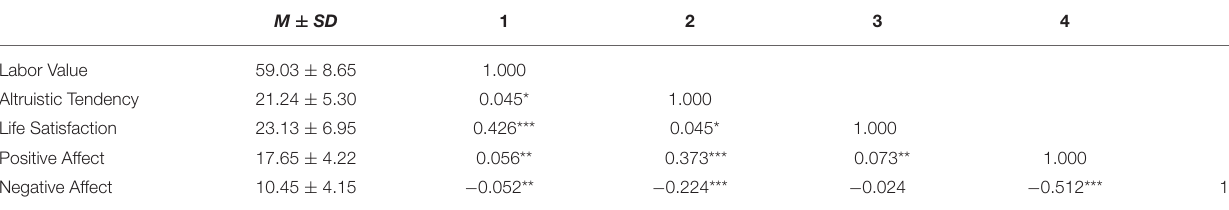
TABLE 1 | Descriptive statistics and zero-order correlations for all variables ( N =